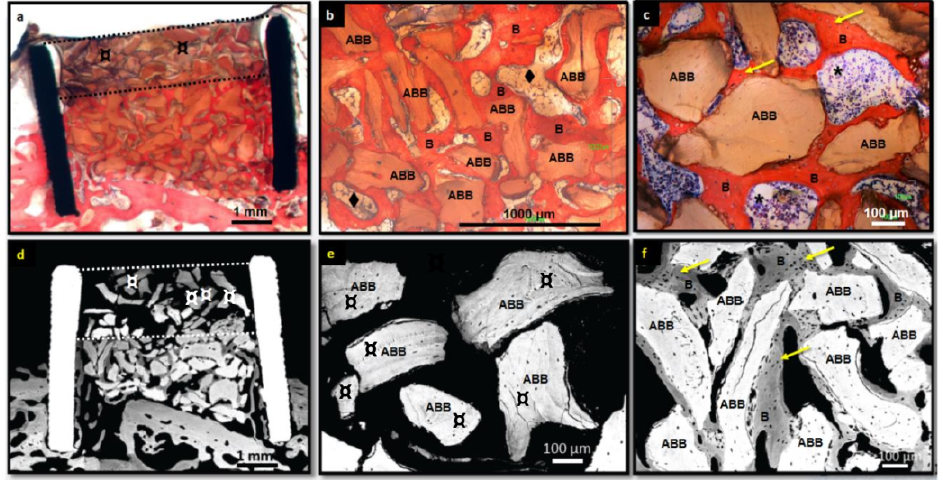
Figure 6. Histological ( a – c ) and BS-SEM images ( d – f ) of rings implanted with ABB granules. Rings remained almost full to the top of the cylinder (upper dotted line) with notable remaining granules of ABB ( a , d ). Non-osteointegrated granules were surrounded by connective tissue at the upper part of the cylinder ( a , d , e ). Vertical bone growth achieved the middle of the cylinder height (lower dotted line) ( a , d ). A very well osteointegrated particles surrounded by new bone were observed in all images, except e, which showed non-osteointegrated material present at the upper part of the cylinder. No changes in particle morphology after implantation were observed ( b , c , e , f ). Mature osteocytes were present at the newly formed bone ( c , f ). (Legend: B: newly formed bone; ¤ : non- osteointegrated granules; * : hematopoietic bone marrow; (cid:7) : adipose bone marrow; yellow arrows: osteocytes